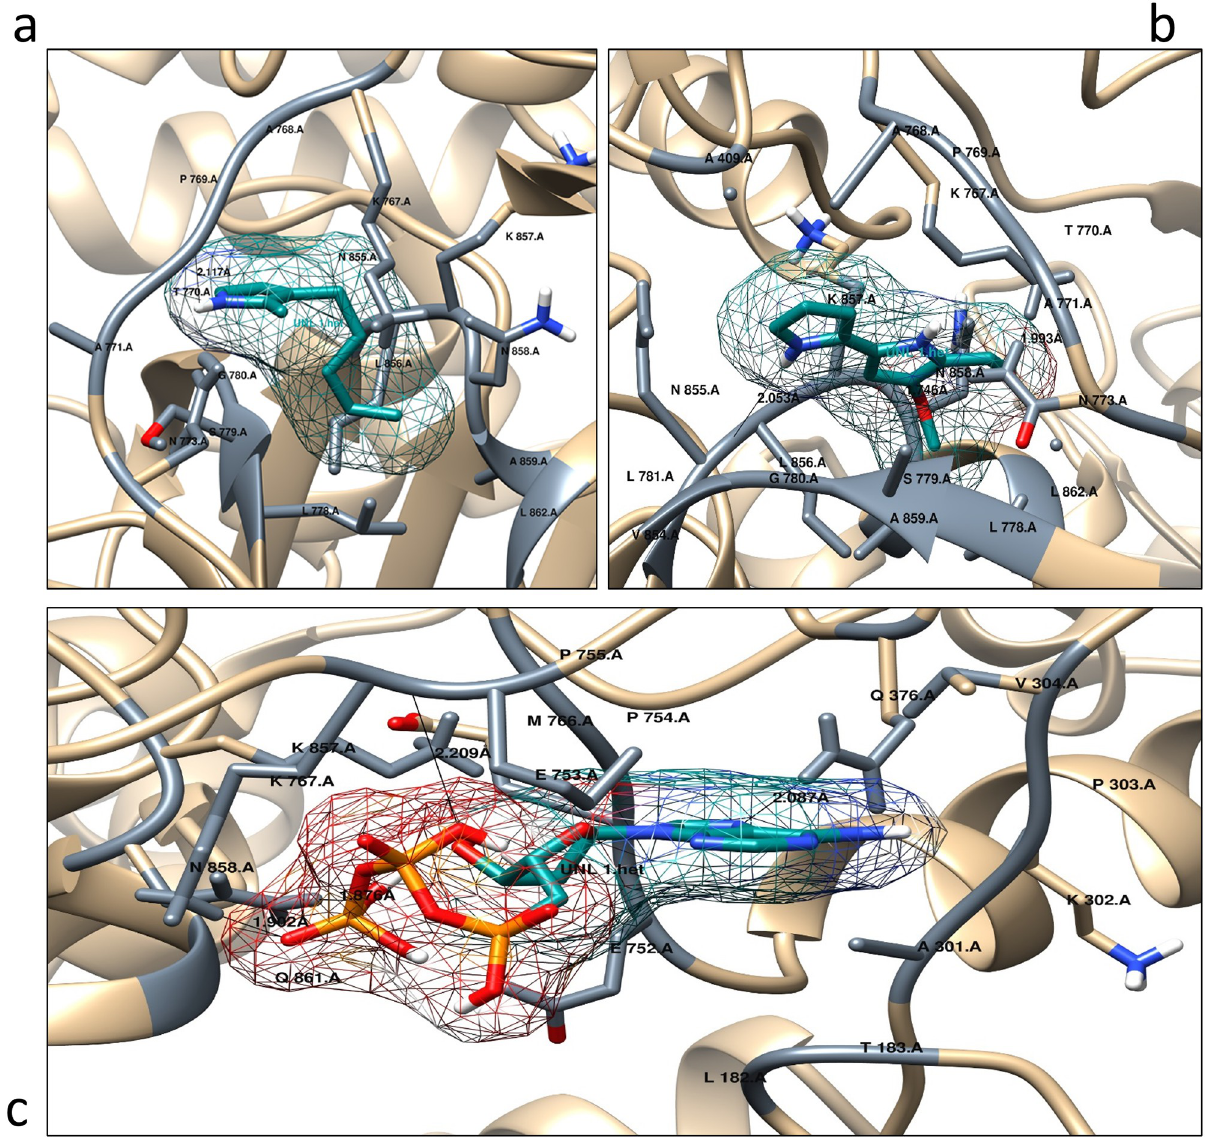
Fig 6. 3D Intermolecular hydrogen bonding interactions of protein and ligand. Protein ligand interactions generated using LigPlot. (a) 2-Methyl- 3-n-amyl-pyrrole (MAP), (b) 4-Methoxy-2,2’-bipyrrole-5-carbaldehyde (MBC), and (c) Adenosine triphosphate (ATP).